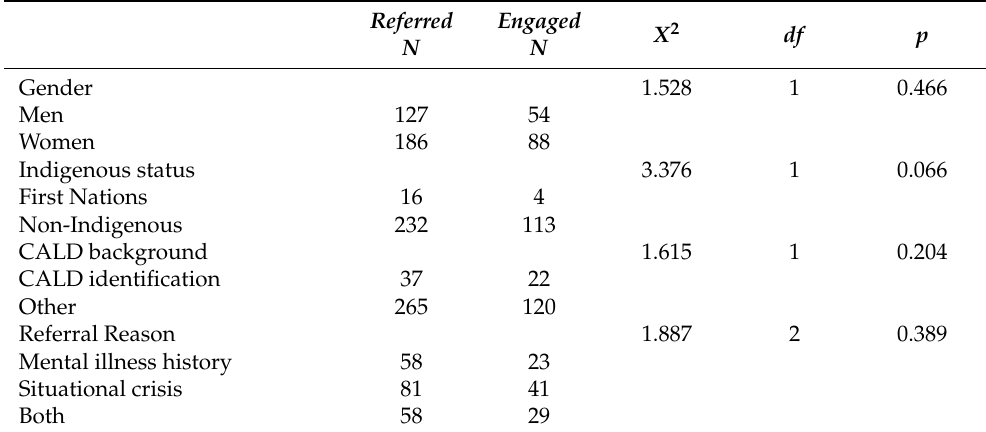
Table 1. Participant demographic information and reason for referral by referral and engagement